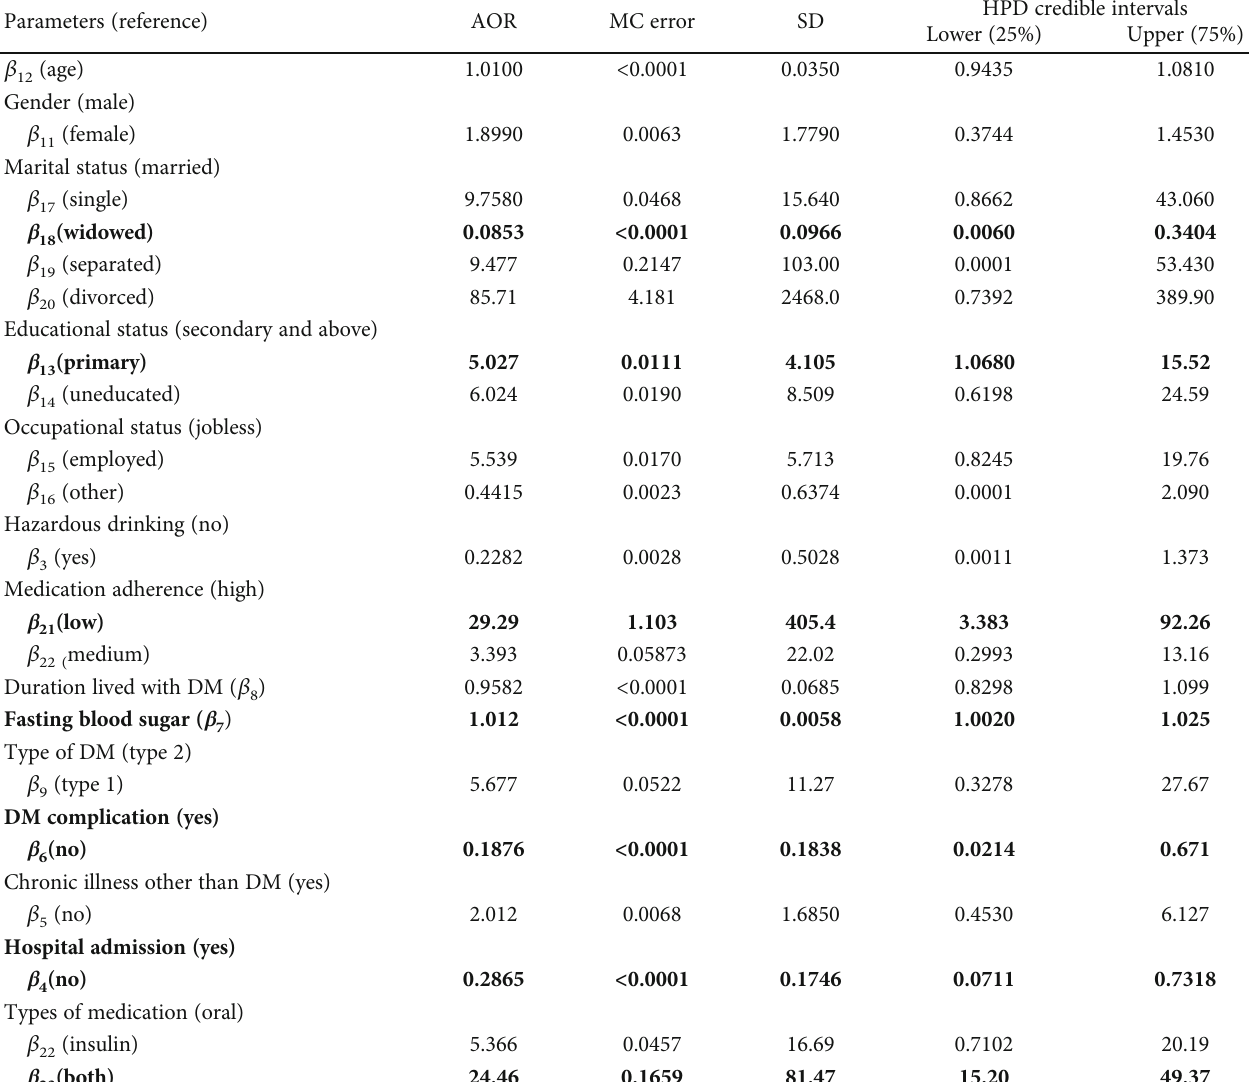
Table 3: Summary statistics for the posterior distribution of model